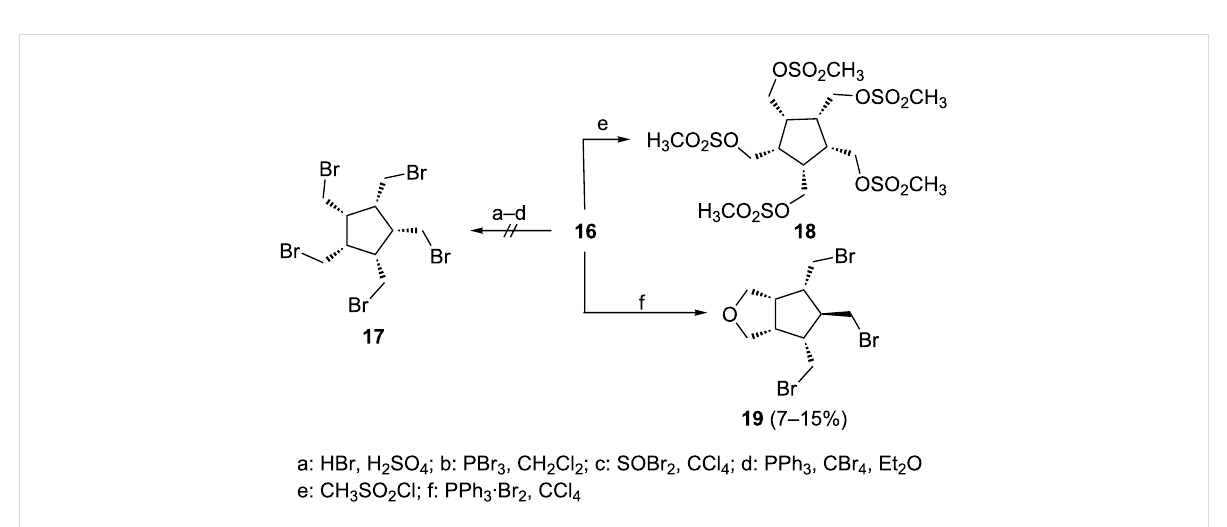
analytical data of 19 can be found in Supporting Information File